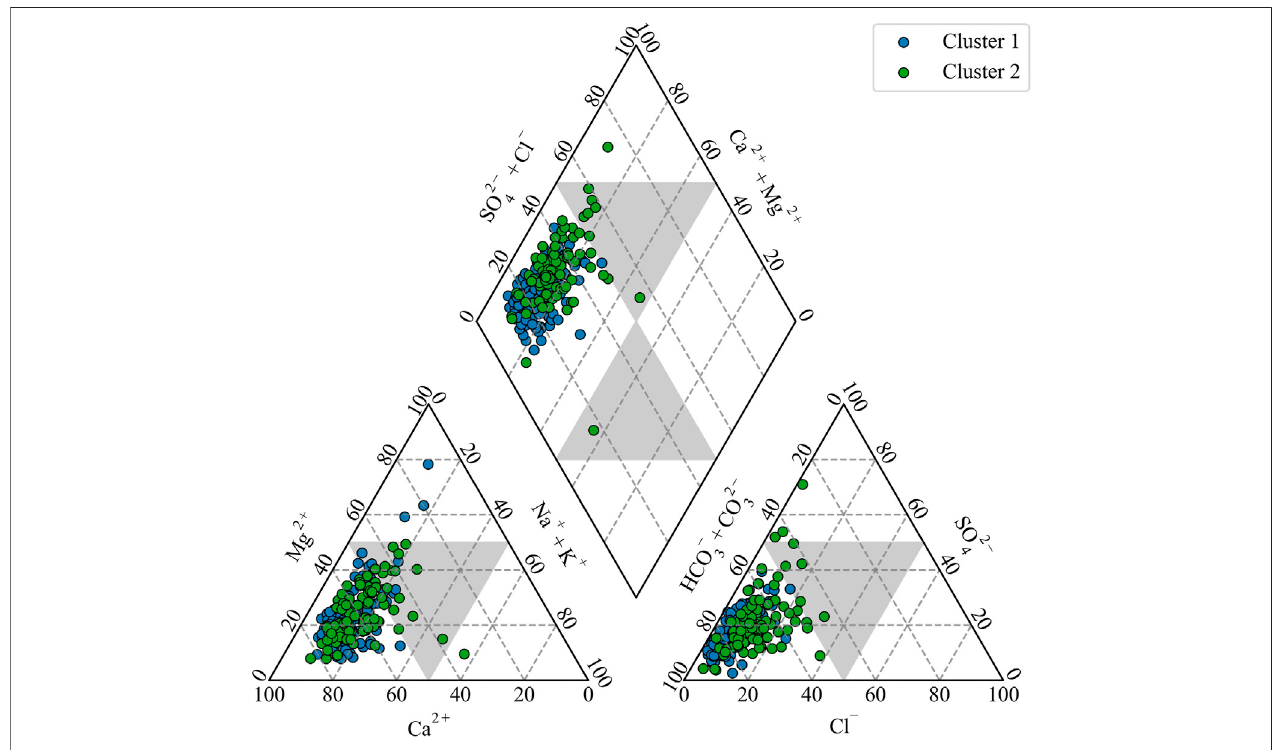
FIGURE 3 | Piper plot of the groundwater samples. The points are divided into two clusters by FCM: the blue points are the fi rst cluster and the red points are the second one.